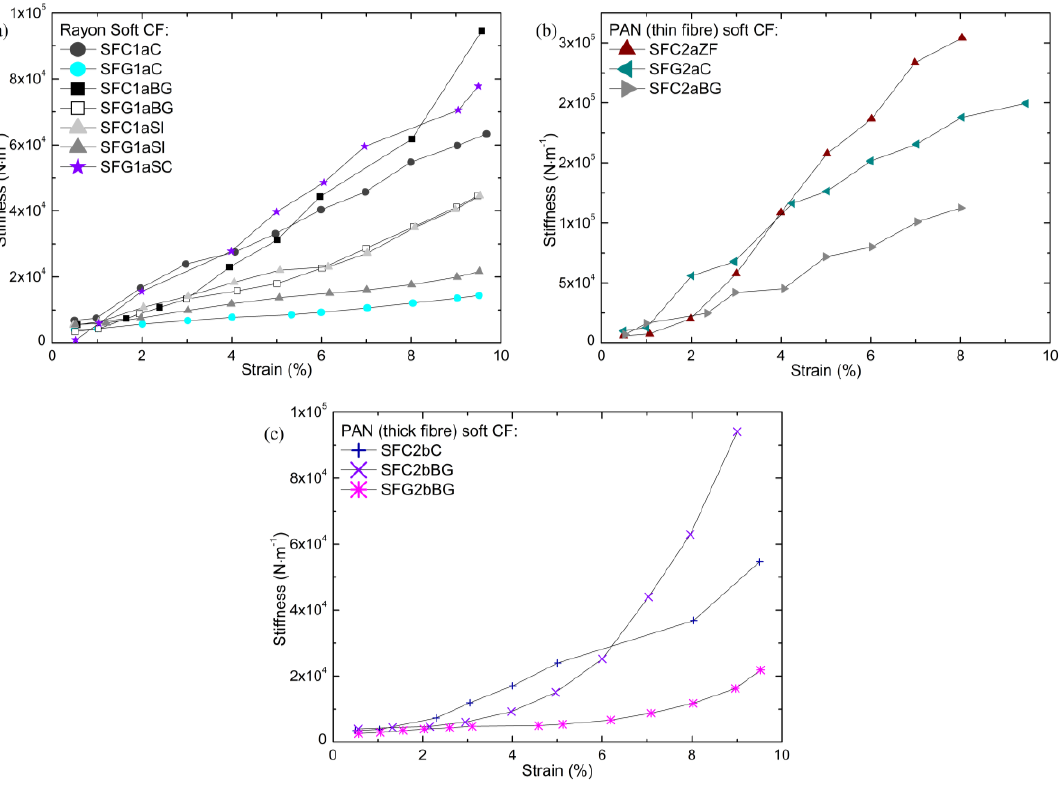
Figure 8. Stiffness vs. strain measurements for the subgroups of soft CFs derived from: ( a ) Rayon, ( b ) PAN (thin fibers) and ( c ) PAN (thick fibers).